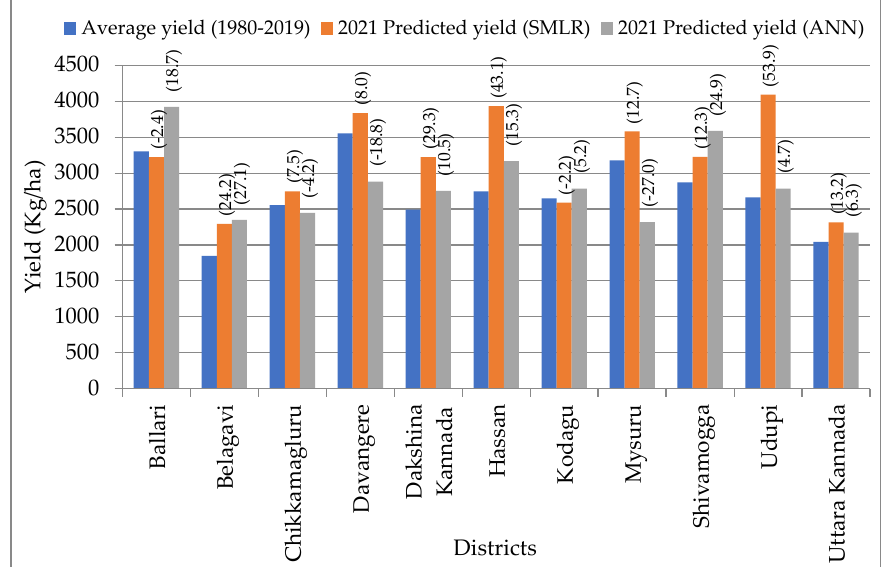
Figure 8. District-wise yield prediction for Kharif rice (kg/ha) using an artificial neural network and a stepwise multiple linear regression during 2021, along with the average yield comparison. Numbers in parenthesis indicate the deviation percentages from the average yields.